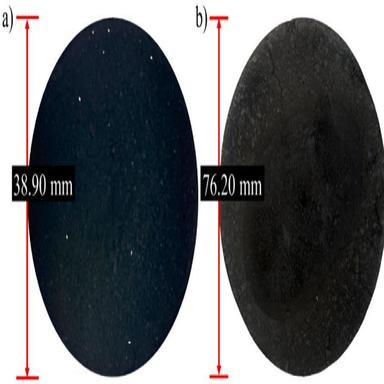
Image of (a) the BNNB-SiCN sample. The diameter of the sample is 38.90 mm as shown in the image. (b) BNNT-SiCN sample. The diameter of the sample is 76.20 mm as shown in the image.